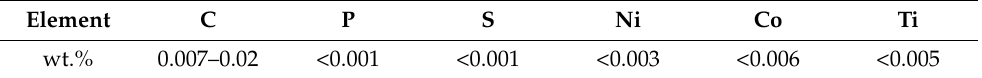
Table 6. Results of the S-OES measurements on compact samples in the as-sintered state (3 samples).